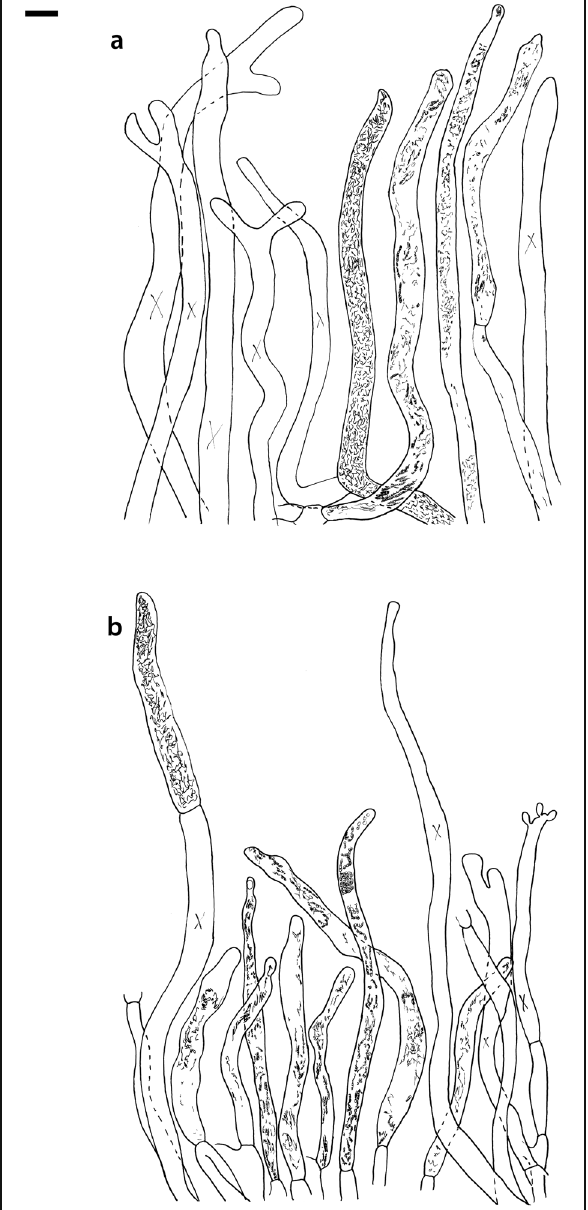
Fig. 18 Russula sp. 1 (RW 1975), pileocystidia. a Near the pileus margin. b Near the pileus centre. Bar = 10 μ m